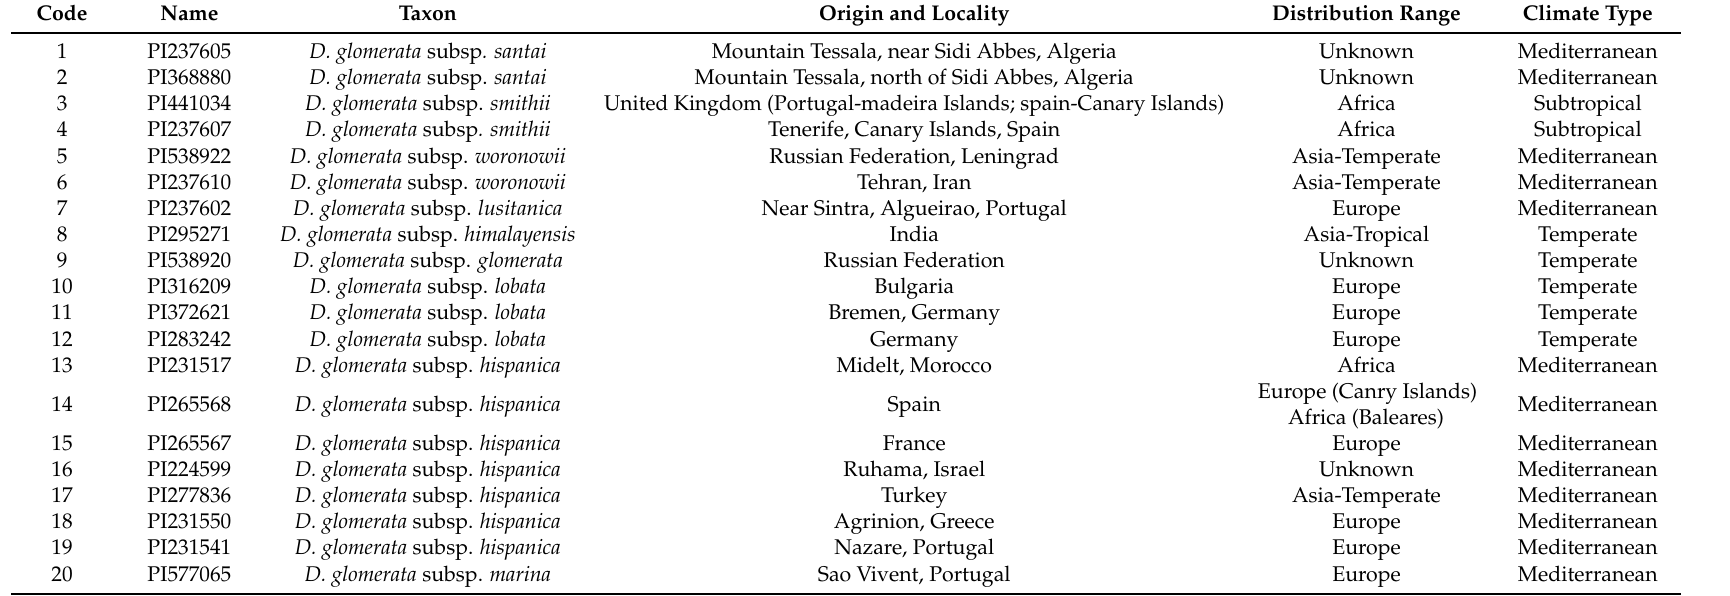
Table 5. Accession numbers, origin, distributional range, and climate type of